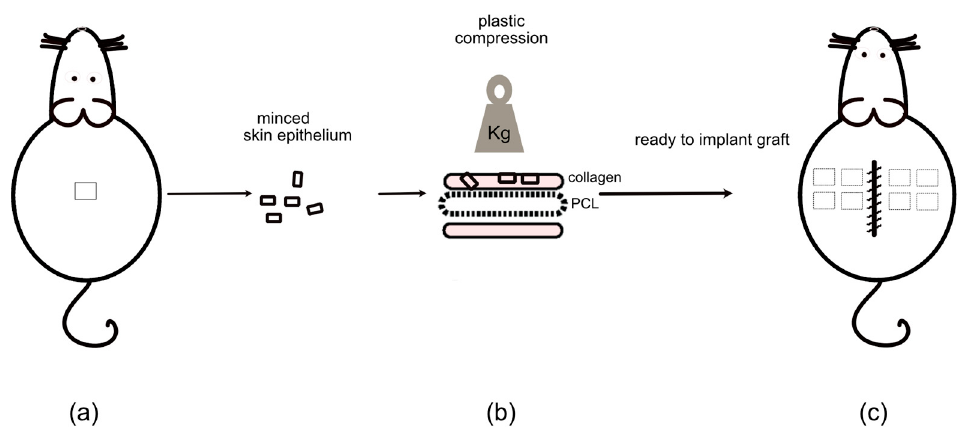
Figure 3. Diagram of the in vivo model. ( a , c ) Schematic illustrating the position of the 1 × 1 cm biopsy on the back of the rat and the subcutaneous placement of the scaffolds (with or without minced tissue transplants). ( b ) Illustration of how the skin biopsy was minced, combined with collagen and PCL, and prepared by plastic compression before grafting back to the same rat in the subcutaneous space of the back.